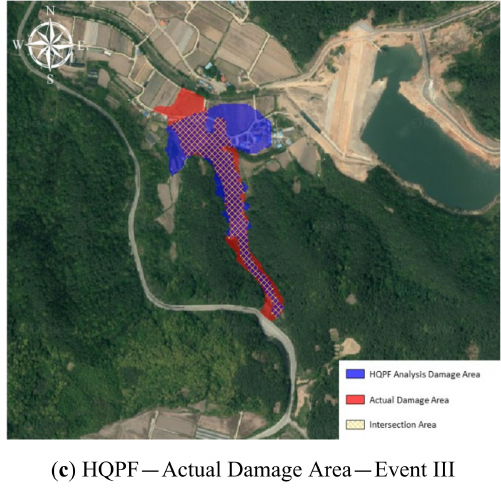
Figure 17. LSSI analysis results. In ( a – c ), the area marked in blue is the HQPF Analysis Damage Area, and the area marked in red is the actual damage area. And the area marked with a yellow checkered pattern means the part where the HQPF Analysis Damage Area and the actual damage area